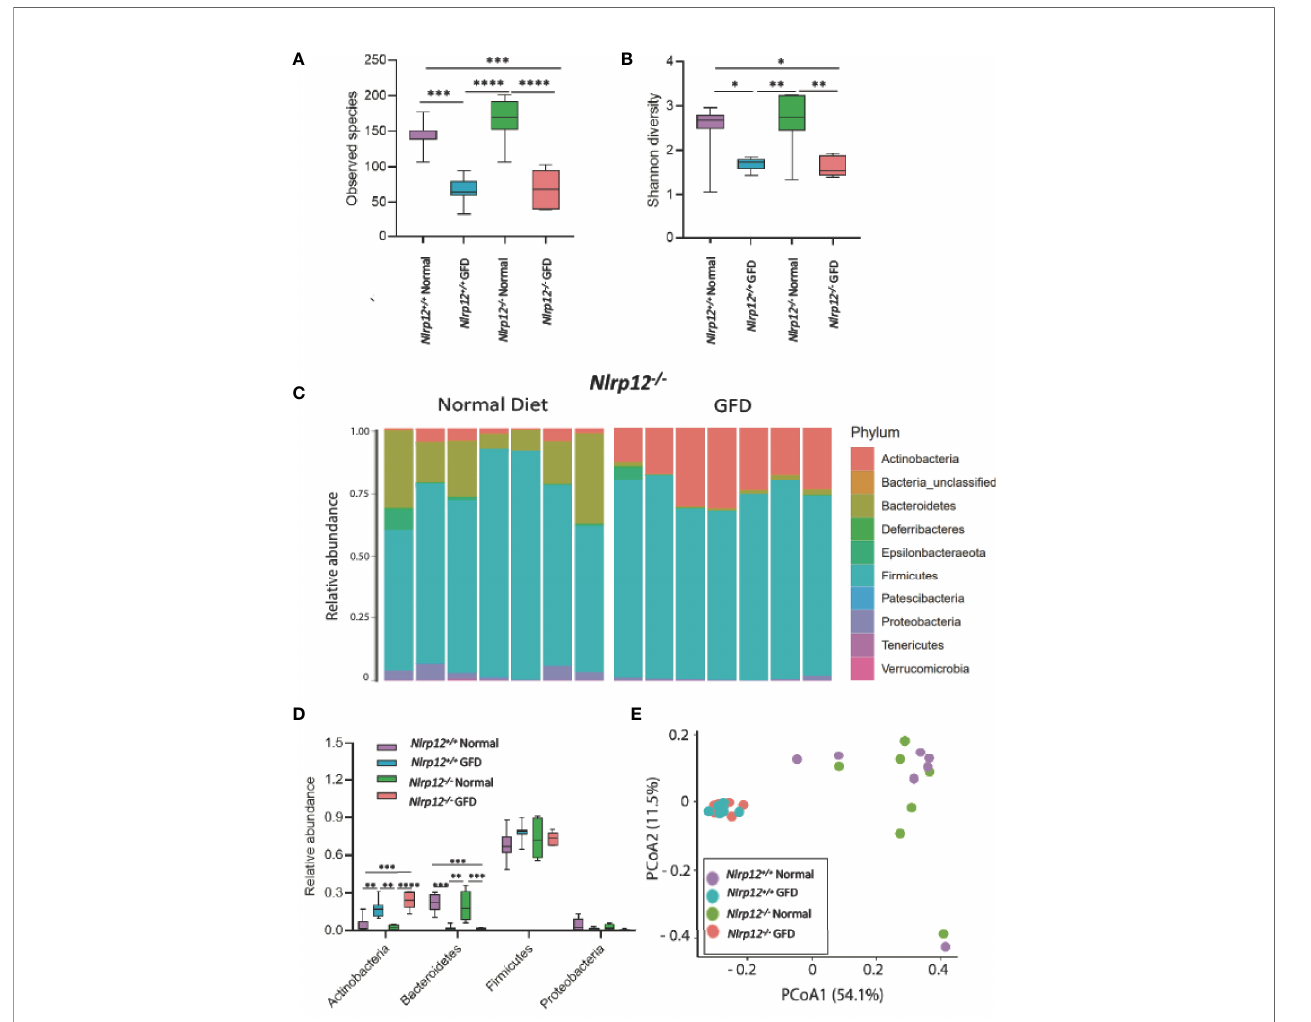
FIGURE 6 | Absence of NLRP12 Has Minimal Effect on Gut Micro fl ora. (A) There is no signi fi cant variation between NLRP12 -/- mice and wild-type mice in the observed species present, either for normal diet or GFD. (B) This trend is also observed in Shannon Diversity. (C) Upon assessment of the relative abundance of phyla in the NLRP12 -/- gut microbiome, the most abundant phyla present is Firmicutes. While the next most abundant phyla is dependent on diet type – Bacteroidetes is the second most abundant phyla for mice adhering to a normal diet, while this phyla was signi fi cantly diminished in GFD mice. (D) There is no signi fi cant variation between NLRP12 -/- mice and wild-type mice in the observed species present, either for normal diet or GFD. (E) There is a clear clustering of the groups in PCoA analysis with clusters occurring based on diet-type. GFD, n = 7 ; normal diet, n = 7. *p < 0.05, **p < 0.01, ***p < 0.001, ****p < 0.0001